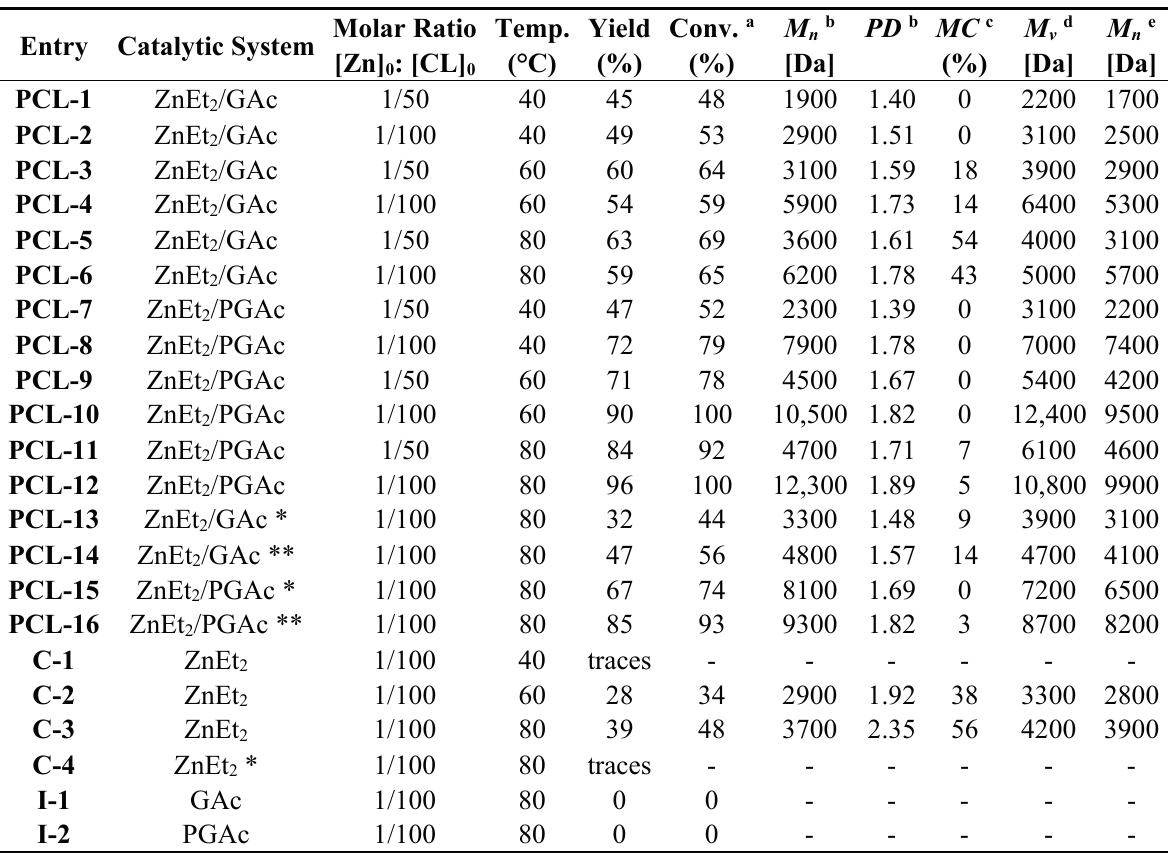
Table 1. Homopolymerization of CL in the presence of ZnEt 2 /GAc and ZnEt 2 /PGAc catalytic systems.